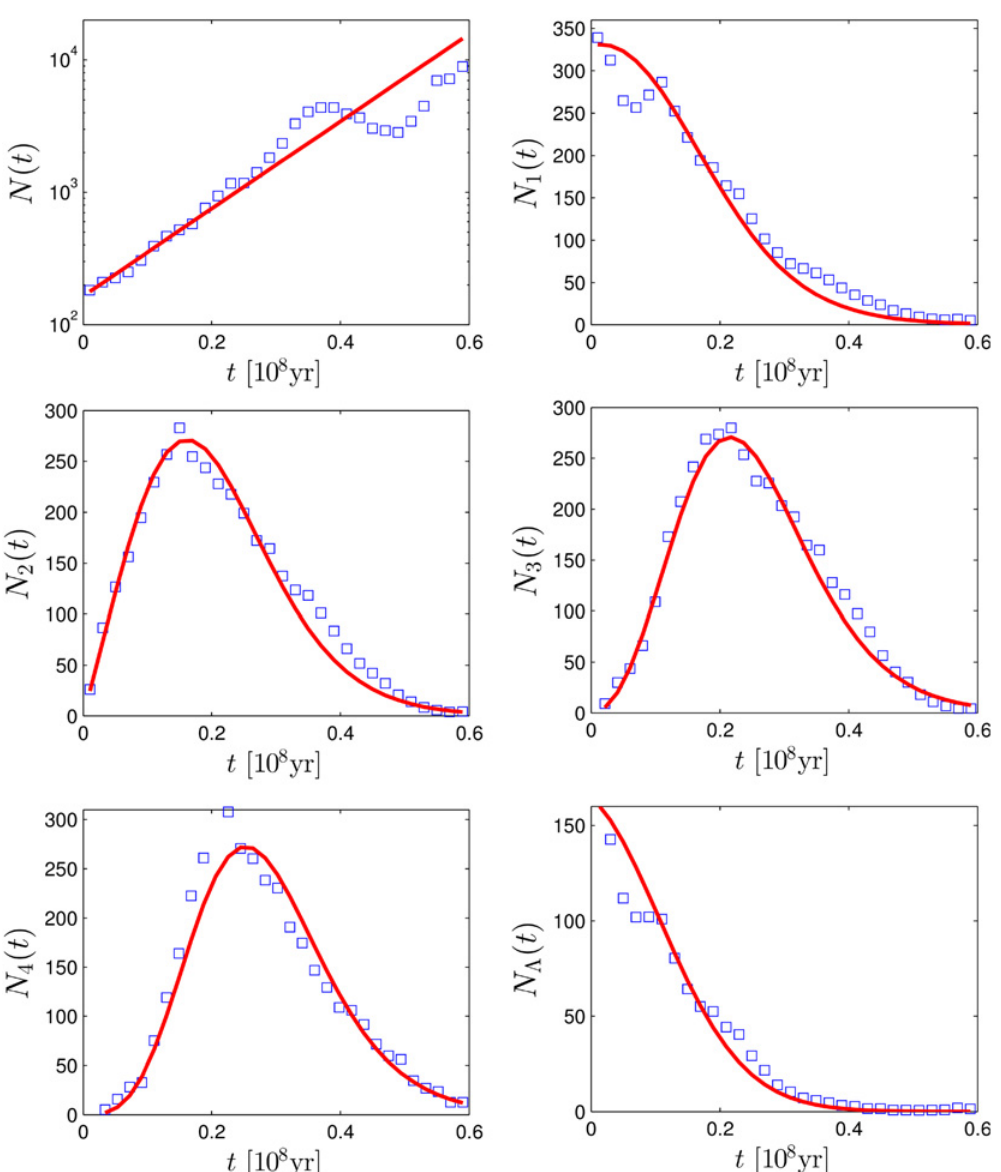
Fig 5. Comparison of analytic predictions to the pairwise distances data of Sylviidae family with M = 75 species taken from the database [28] with t (cid:1) 0.6 × 10 8 Myr. The markers represent the empirical data, while the lines represent the analytic formulas with fitted parameters. (a) Pairwise distance distribution. (b) Minimal distance distribution.(c-e) n -minimal distance distribution. (d) Cherries distance distribution. The lines are based on following set of parameters: λ − μ = 15.2 × 10 − 8 yr − 1 and λσ = 4.6 × 10 − 8 yr − 1 . For μ = 0, 0.2, 0.4, 0.6, 0.8 × λ this corresponds respectively to σ = 0.3, 0.24, 0.18, 0.12,